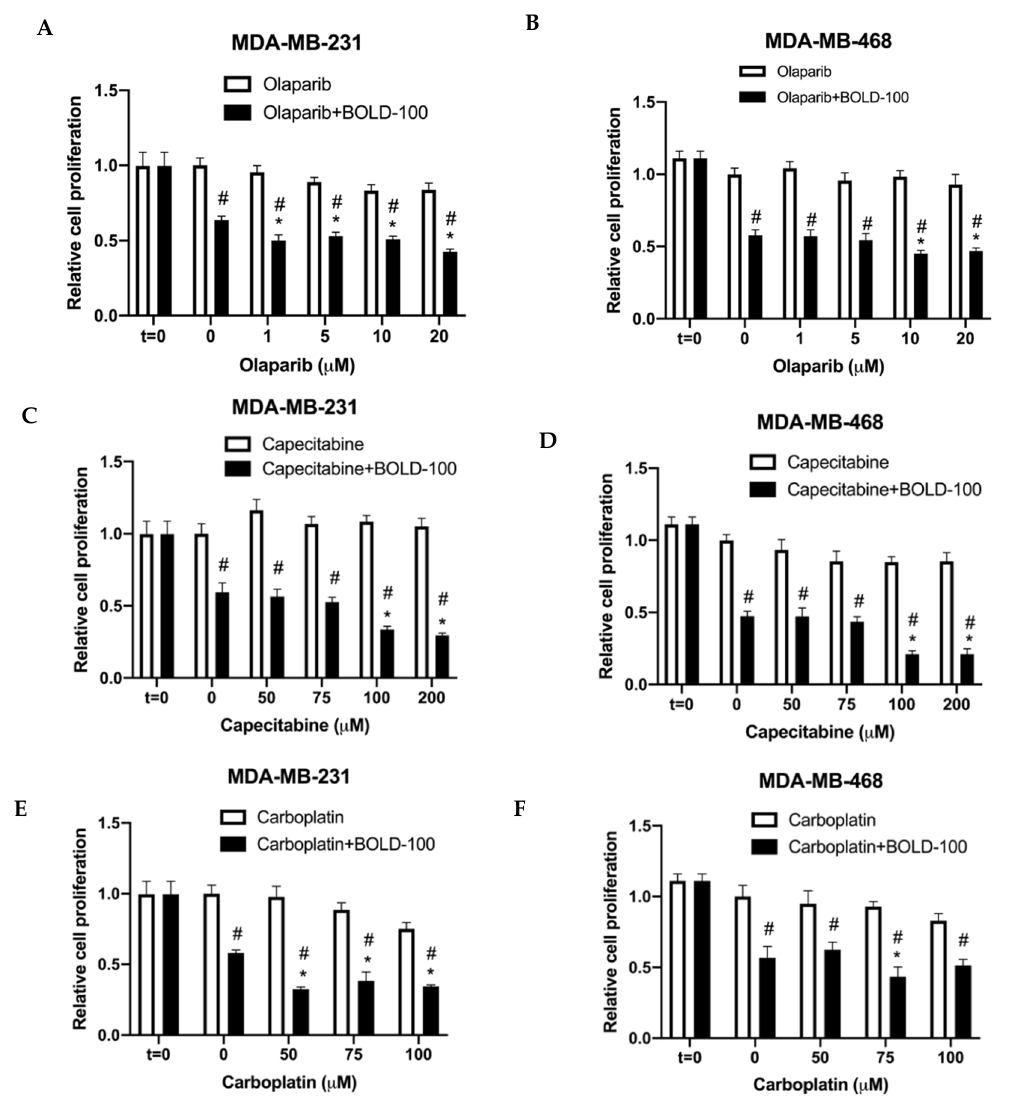
Figure 5. BOLD-100 suppressed growth of TNBC breast cancer cells in combination with anticancer drugs that target the DNA. Cell proliferation was measured using a crystal violet method. Synergistic interactions were analyzed by calculating RI values (see Section 4.11; RI > 1 indicates synergy). ( A ) MDA-MB-231 and ( B ) MDA-MB-468 cells were treated with varying concentrations of